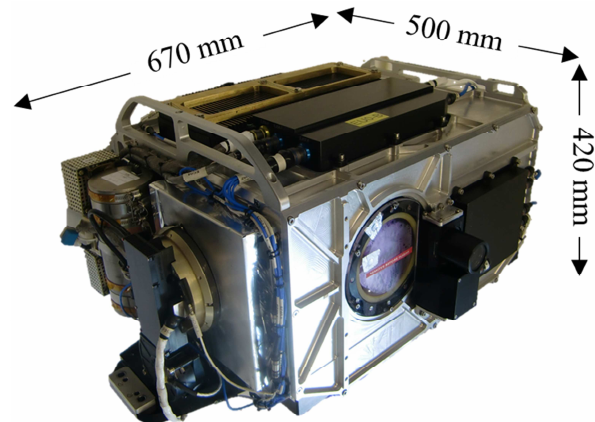
Figure 2. GLORIA Spectrometer ready for installation in the gim- bal. Outer shell with electronic boxes (black), the entrance window (with cover), and the detector module (left side). The interferometer optics with cooling system is housed inside.